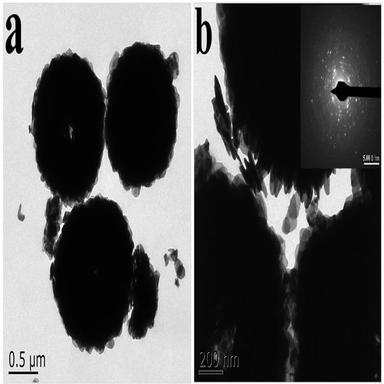
TEM images of Bi2O2CO3 microspheres (aeb).